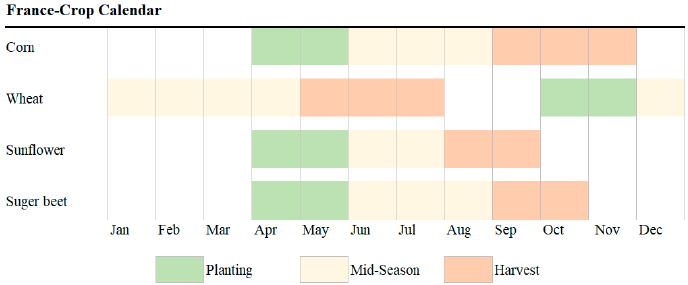
Figure 3. Phenological information of major crops in France.